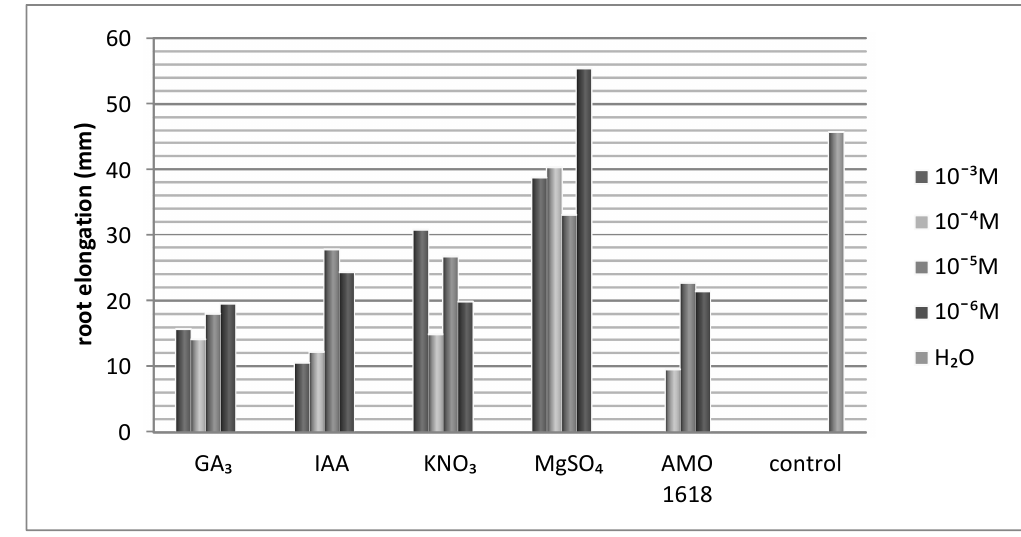
Figure 2. Effects of different plant growth regulators and inhibitor AMO 1618 on Triticosecale root elongation.